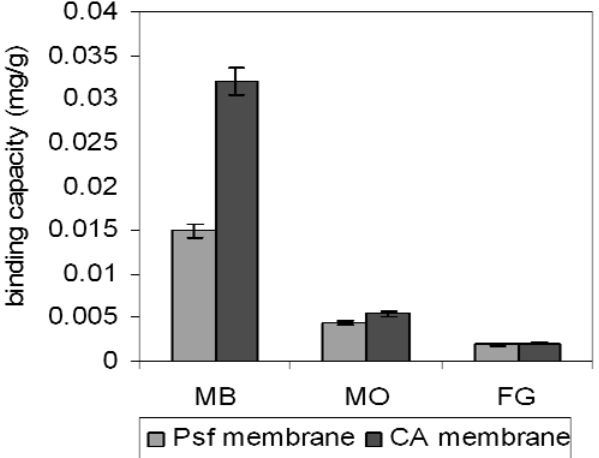
Figure 9. Selectivity studies of CA-MB-MIP membrane and PSf-MB-MIP membrane.